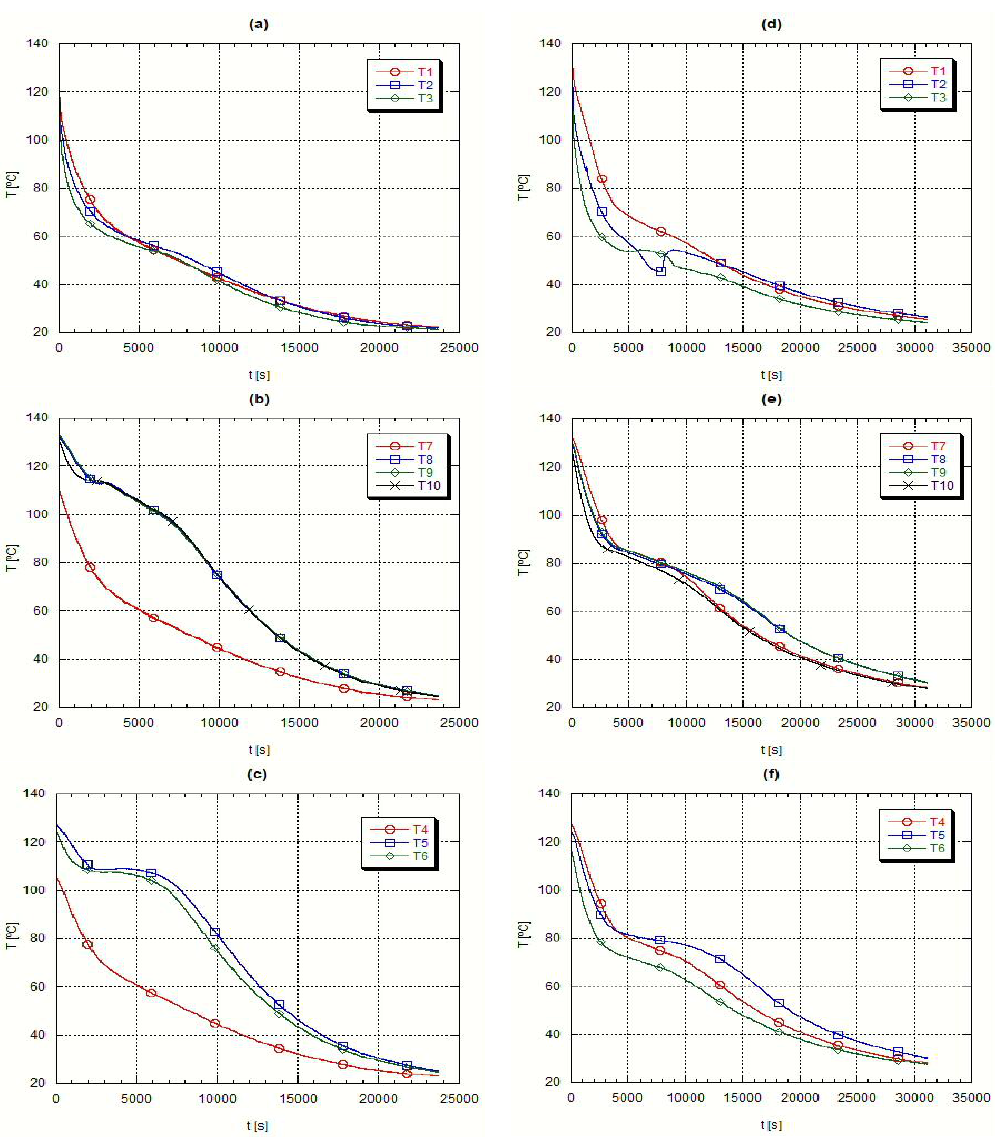
Figure 6. Axial evolution of phase change materials temperature during solidification. Plots ( a – c )—H105; Plots ( d – f )—A82.